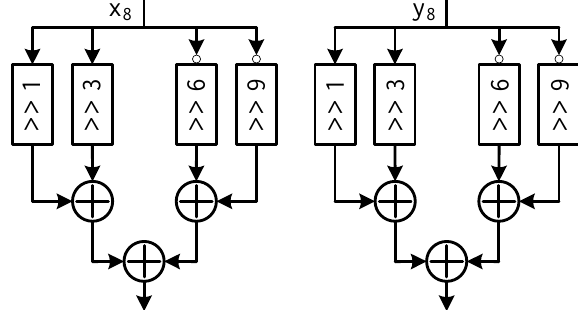
Figure 12. Architecture of scaling of adopted CORDIC module.